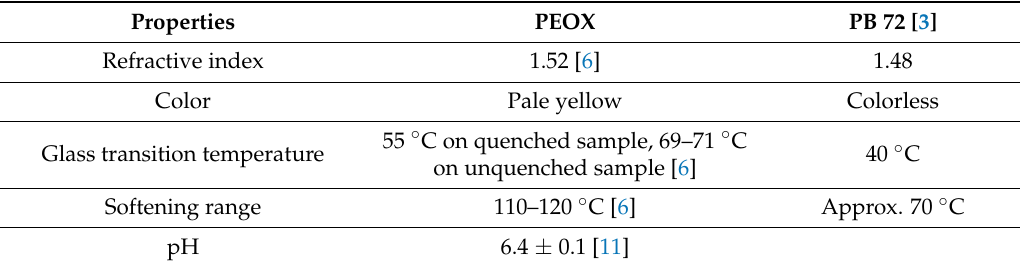
Table 1. Basic properties of poly(2-ethyl-2-oxazoline) (PEOX) and Paraloid B72 (PB 72) reported in the literature.